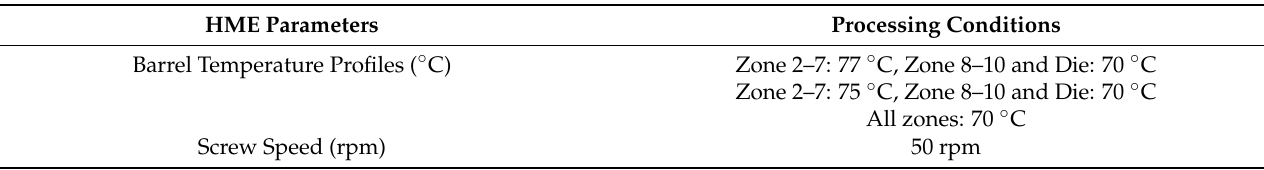
Table 4. Hot-melt extrusion (HME) processing conditions to study the effect of HME processing temperature on lipid-based formulations and drug release